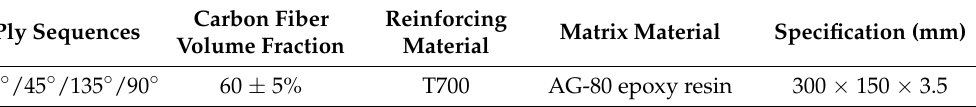
Table 2. The structural parameters of carbon fiber reinforced plastic